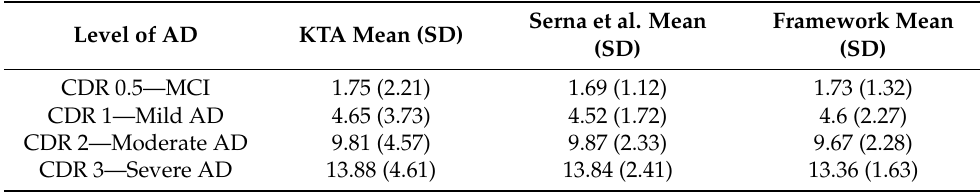
Table 3. Comparison of the KTA and Serna et al.’s model with our framework values; mean values and standard